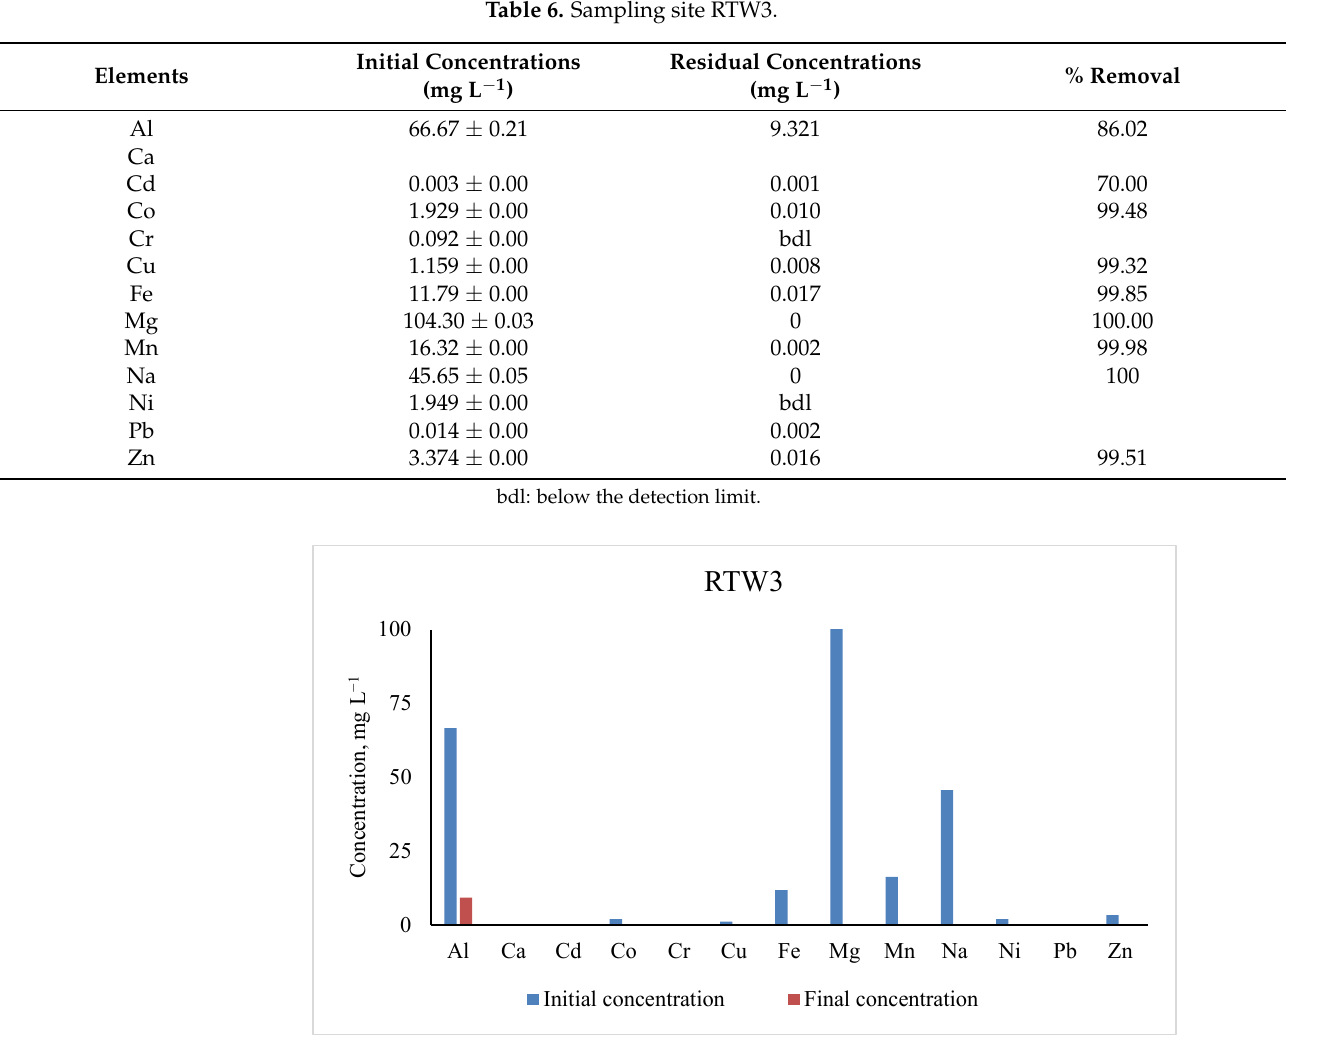
Table 6. Sampling site RTW3.